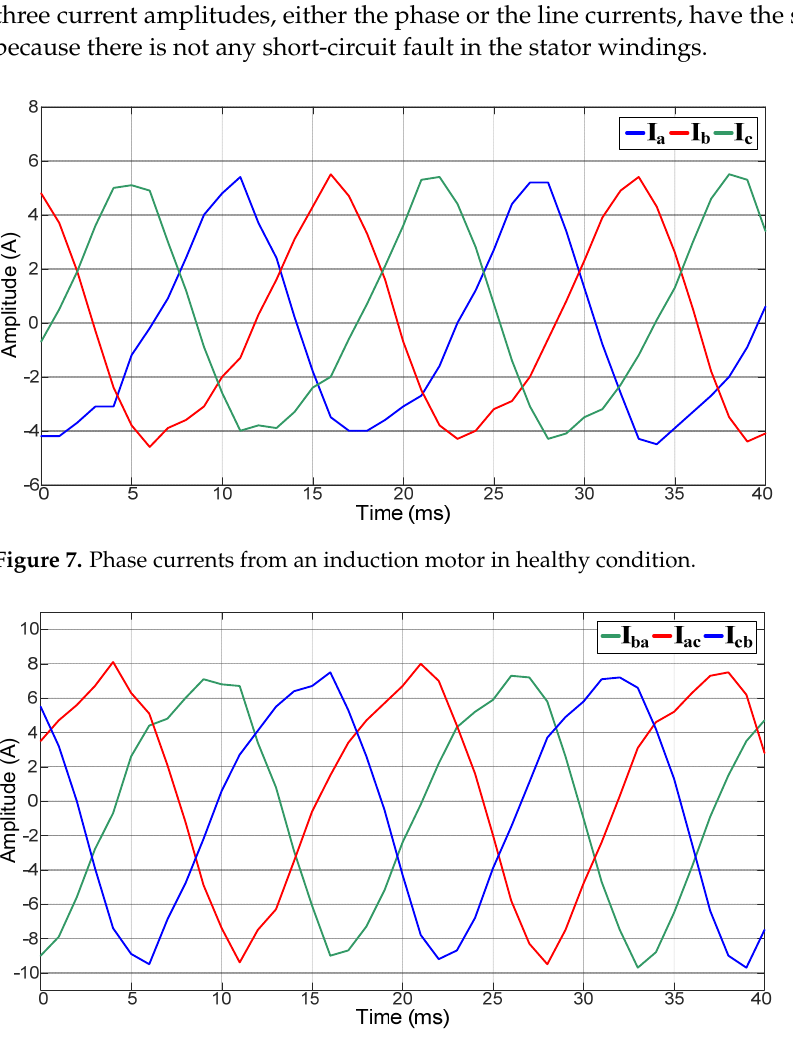
Figure 6. Experimental setup.